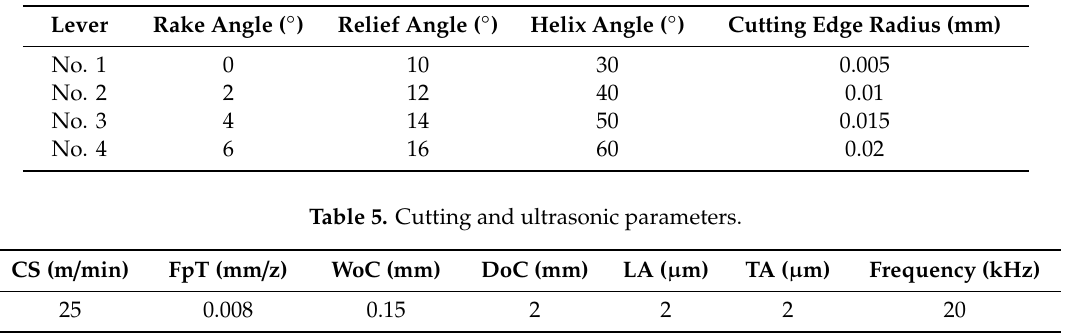
Table 4. Simulated design for tool geometry parameters L 16 (4 5 ).